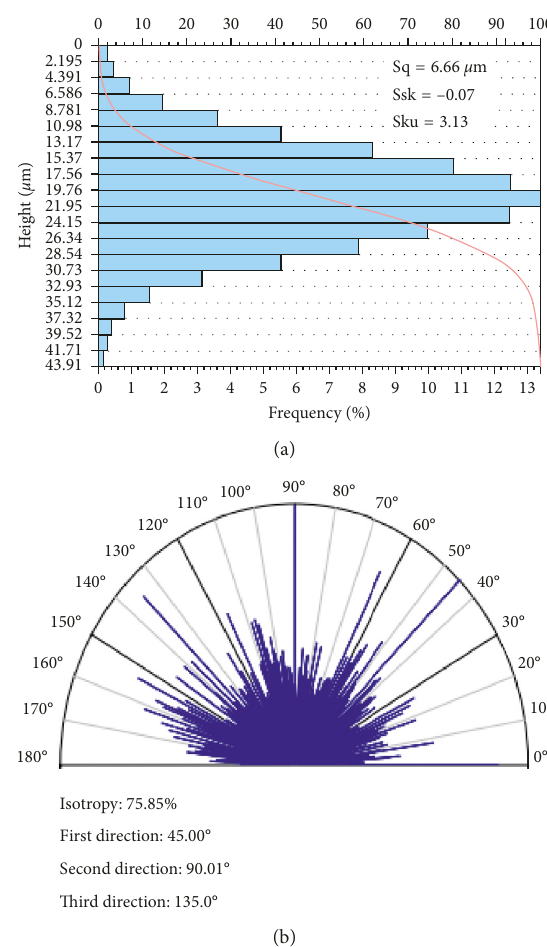
Figure 4: (a) Histogram of height distribution of a representative shot-blasting steel surface and (b) the polar graph with texture